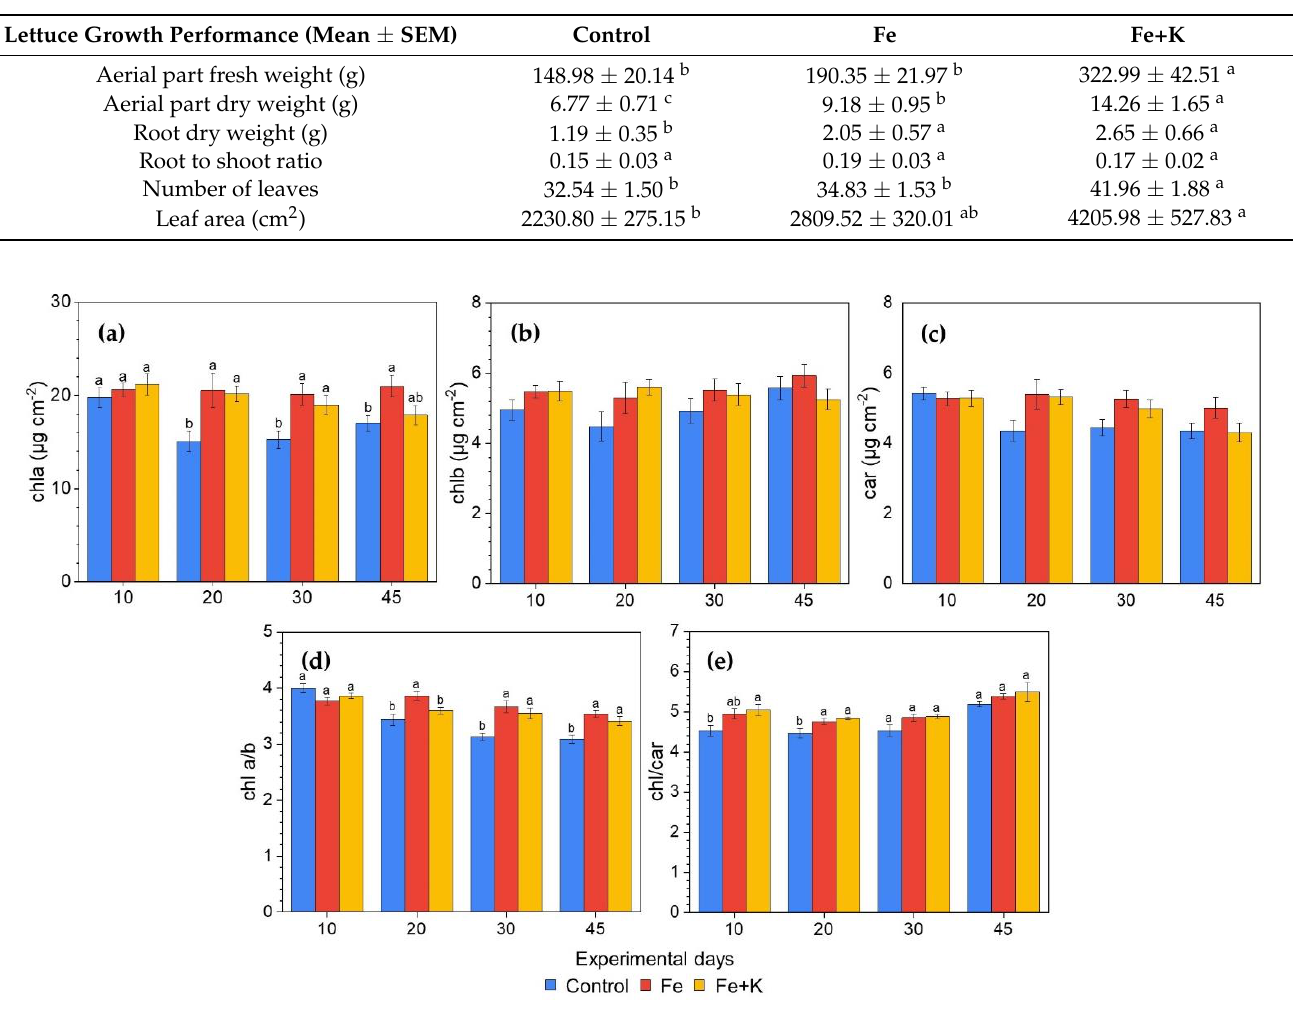
Figure 2. Concentration of photosynthetic pigments and their ratios during the experimental period (Mean ± SEM, n = 15). ( a ) chla ; ( b ) chlb ; ( c ) car ; ( d ) chl a to b ratio; ( e ) total chls to car ratio. Different letters indicate significant differences among treatments at each experimental day ( p < 0.05) and the absence of letters in (b) and (c) denotes no significant differences in any experimental day.